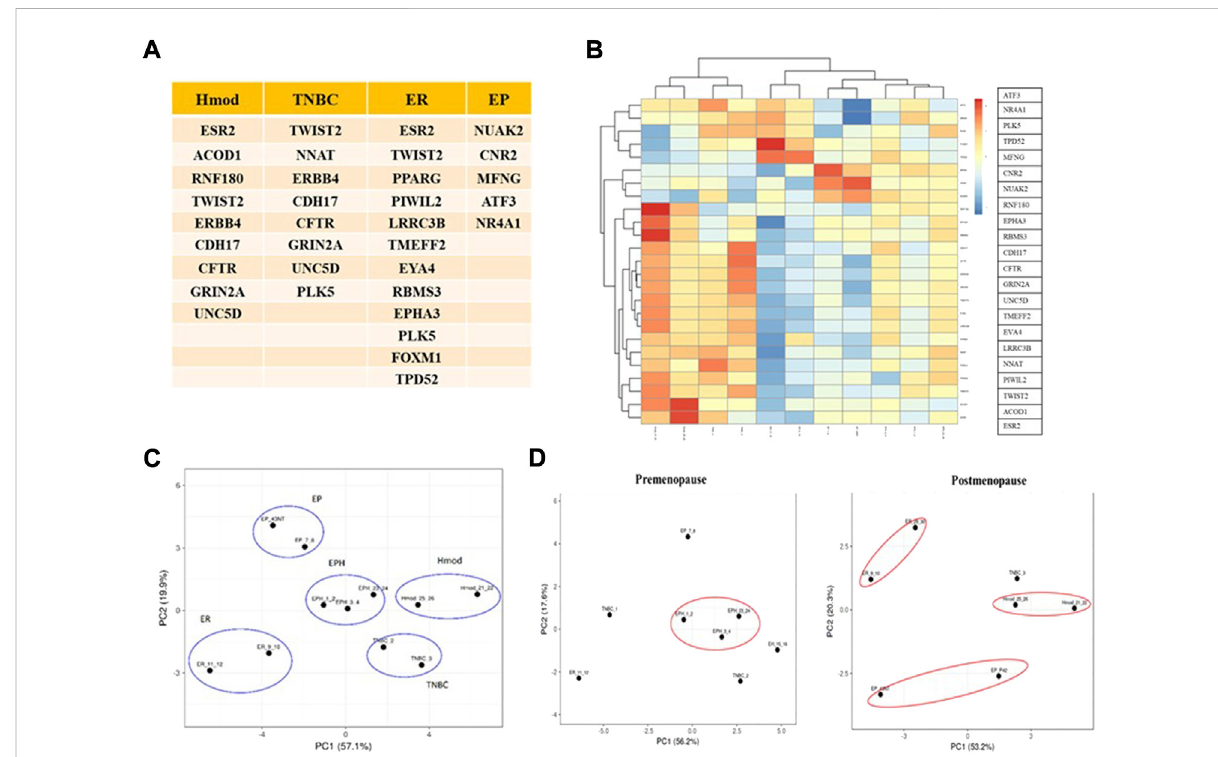
FIGURE 4 (A) Table depicting unique mRNAs withpotential as Indian-speci fi cbiomarkers derived fromdifferentsubtypes. (B) Heatmap ofuniquemRNAs chosen as potential biomarkers in the Indian population. Blue represents downregulated genes and red represents upregulation. (C) PCA plot showing segregation of Indian patients with selected mRNAs. (D) PCA plots showing segregation with selected mRNAs between pre- and postmenopausal Indian breast cancer